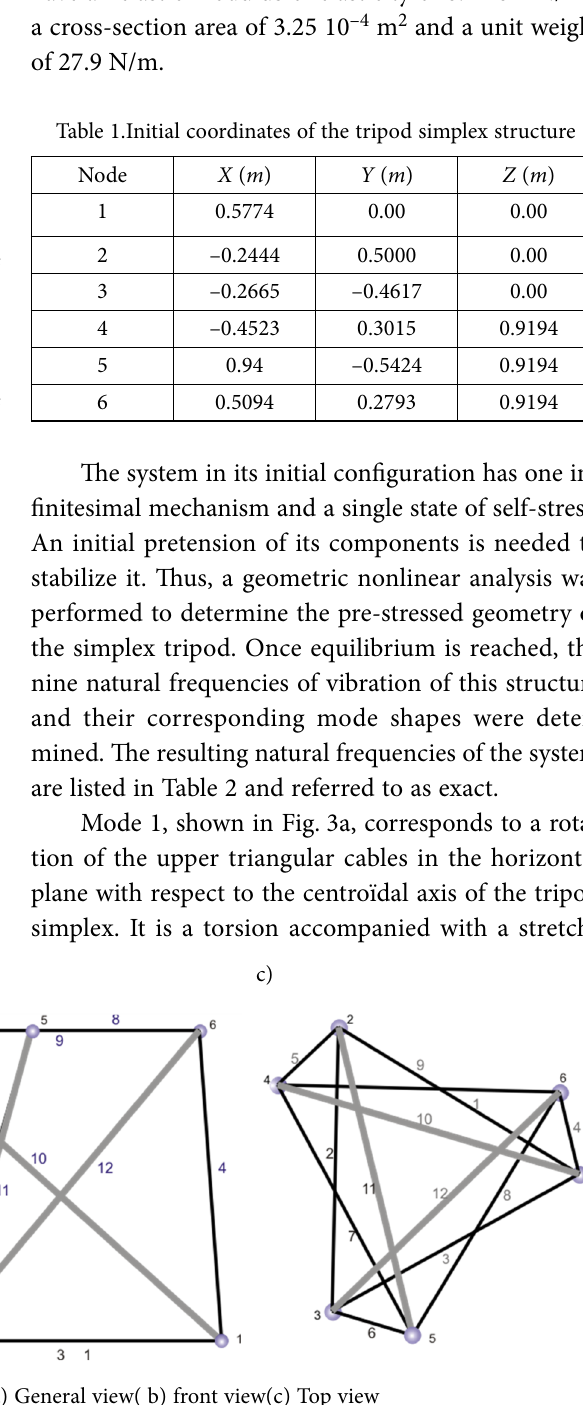
Fig. 2. The stabilized tripod simplex (a) General view( b) front view(c) Top